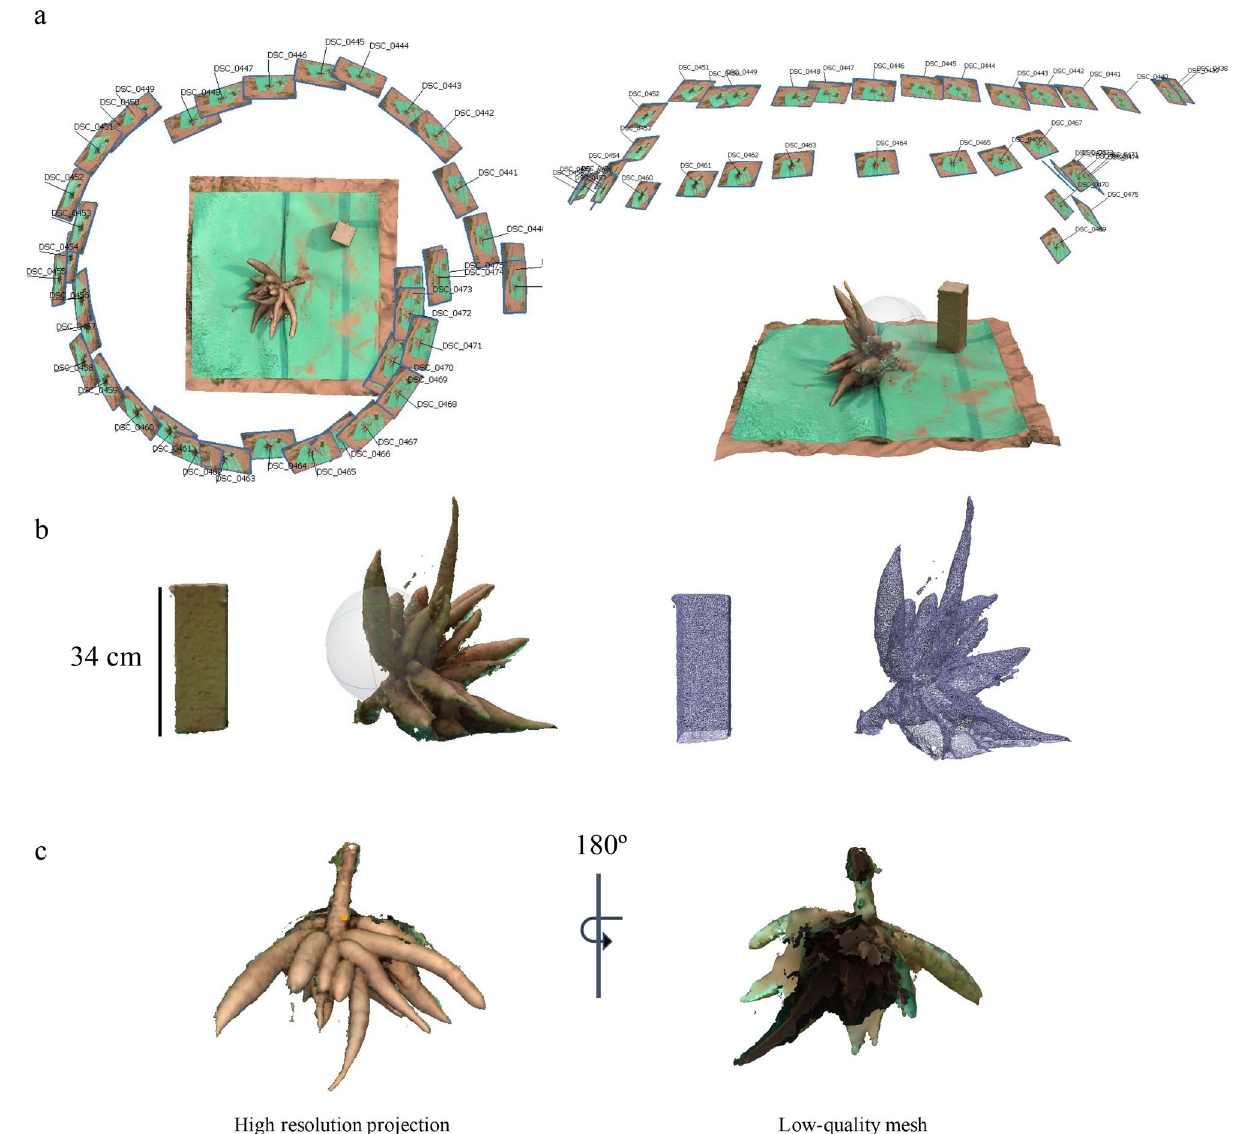
Figure 1. A 3D reconstruction of a CRC from 2D images using Agisoft Metashape Standard 1.6.5 (http:// www. agiso ft. com/ downl oads/ insta ller/). ( a ) A representative image for 3D CRC reconstruction through 360° photo alignment, dense cloud and 3D mesh generation with different camera projections. The root object was placed on a green background with a reference object using a card box (W × L × H: 12.5 × 12.5 × 34 cm). ( b ) An exported .Obj model file with background removed and noise clearing for Blender. ( c ) Projections of 3D root crown at high resolution and low-quality mesh from the blind